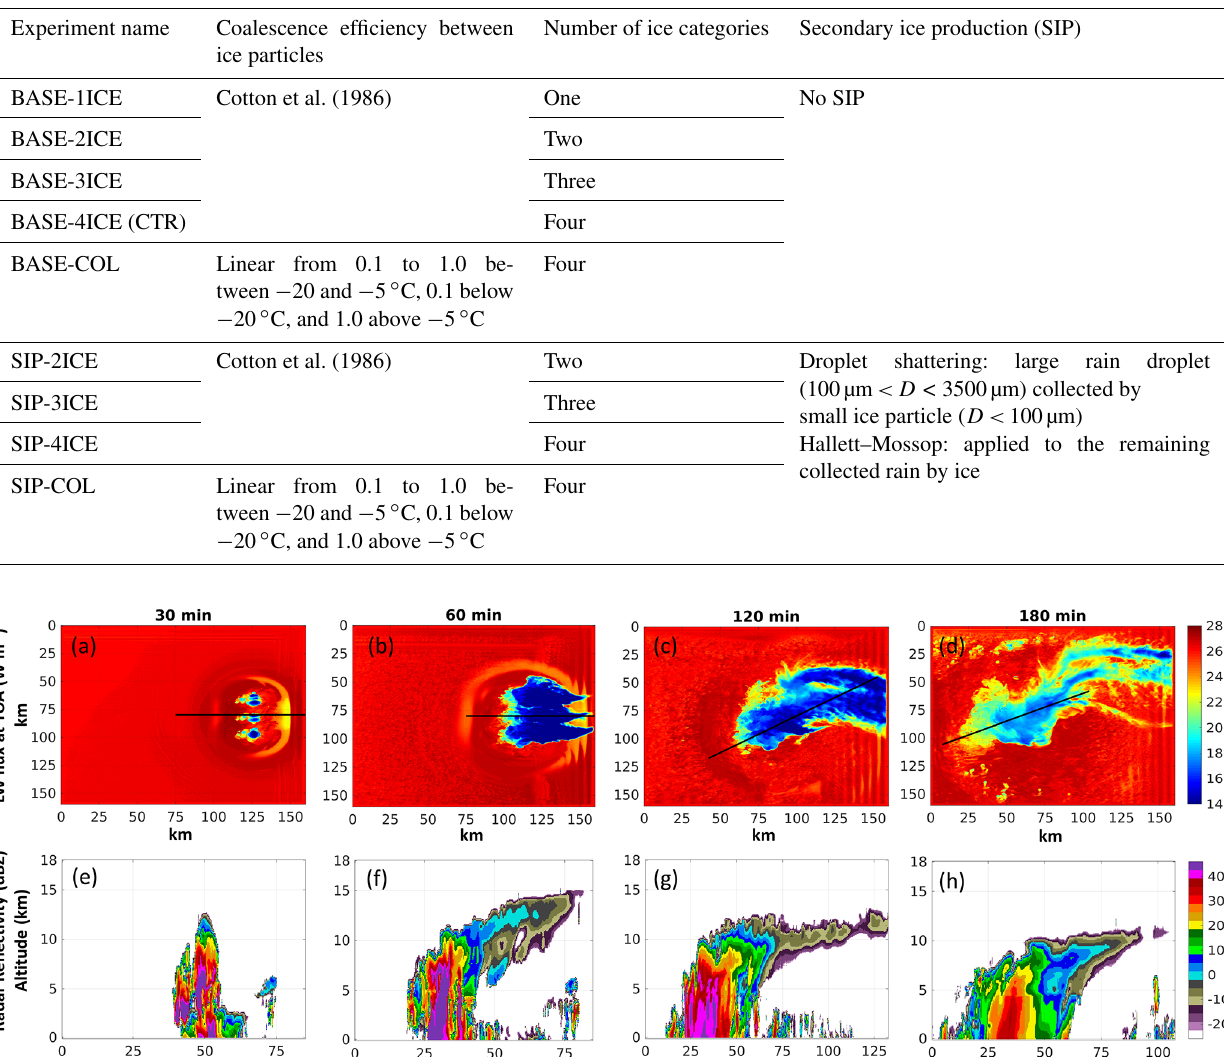
Table 2. List of simulations.